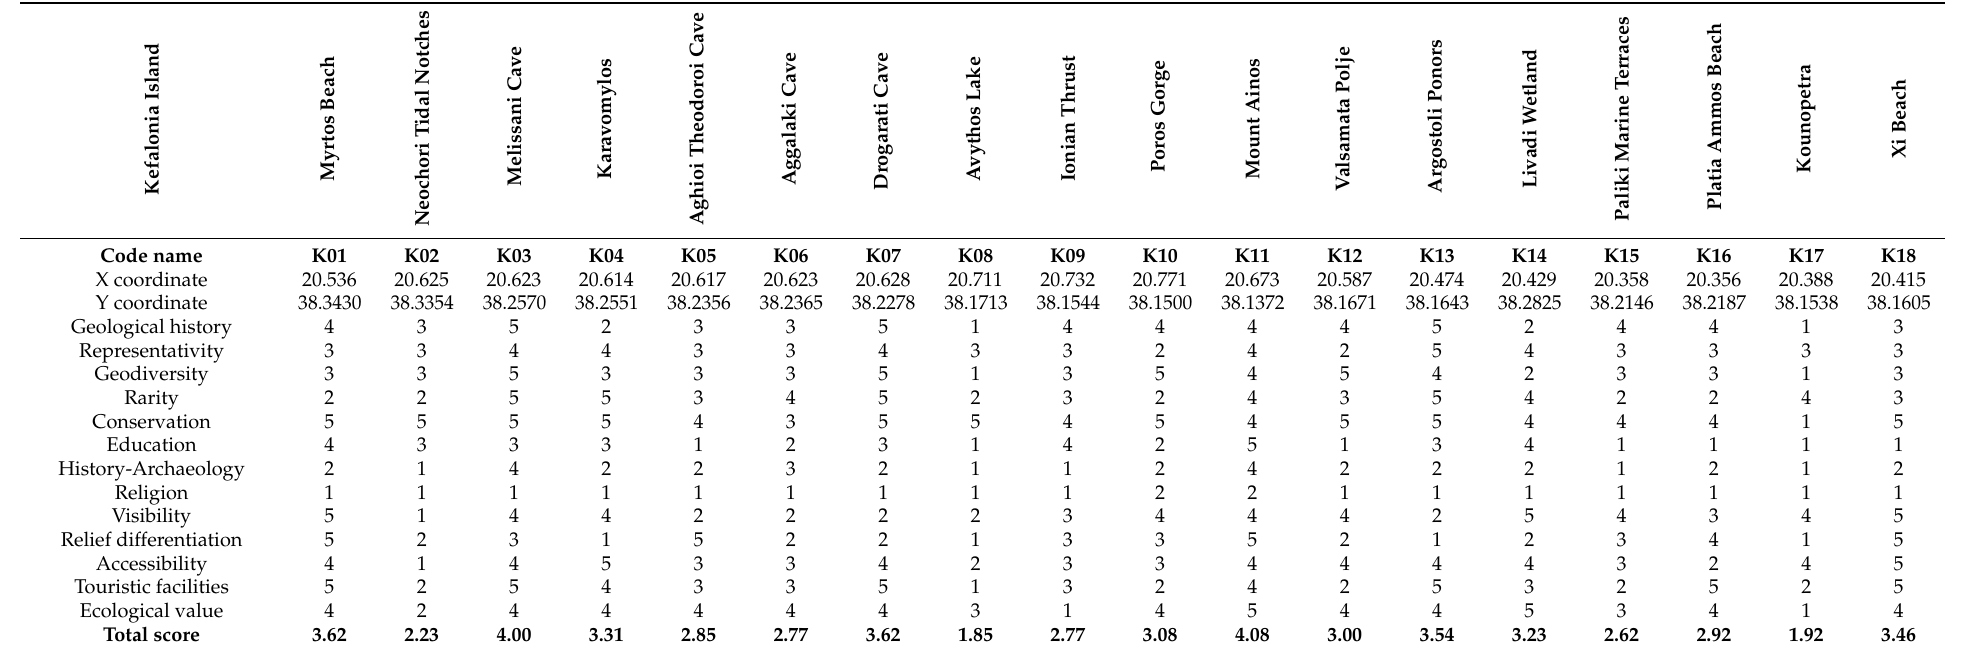
Table 3. Kefalonia island geosites assessment, following the evaluation criteria of Table